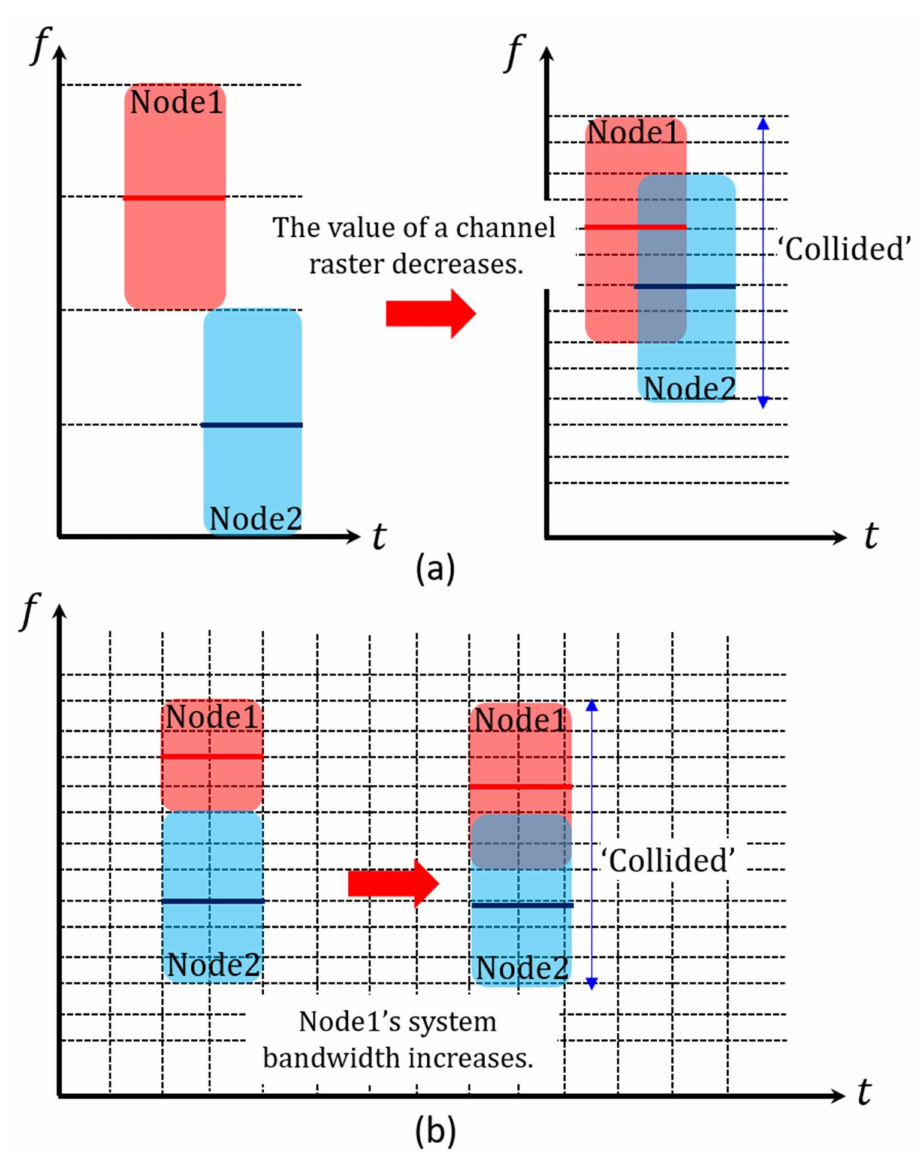
Figure 3. The illustration of the occurrence of a collision. ( a ) A collision induced by the decrease of the value of channel raster. ( b ) A collision induced by the increase of a node’s system